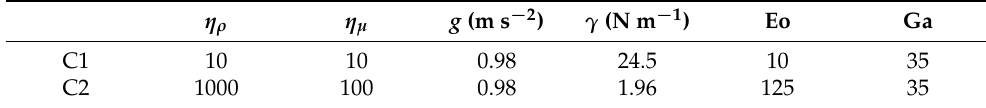
Table 2. Parameters for the 2D rising bubble